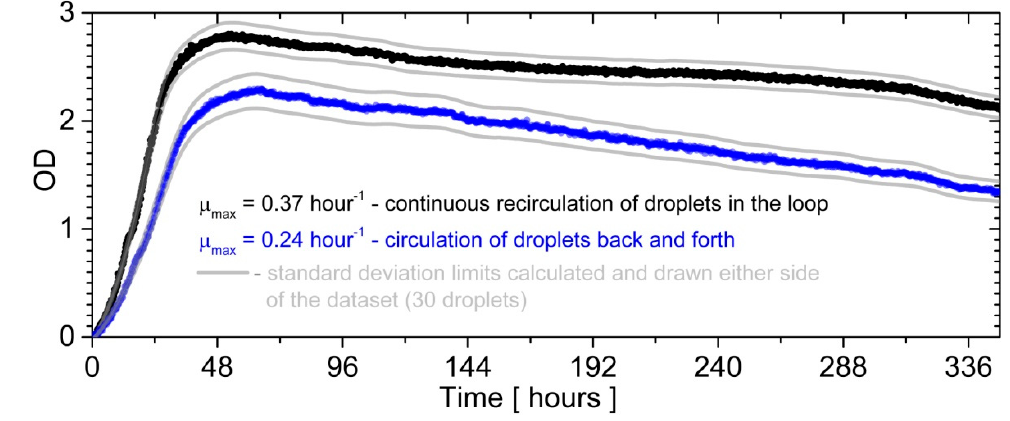
Figure 4. The bacterial growth curve for the long-term incubation of droplets flowing in a microfluidic loop, compared with droplets flowing back and forth in the 1 m long tubing. The optical density (OD) was taken at 600 nm. The black and blue curves represent the average growth calculated from 30 droplets in each case. The maximum growth rate was calculated as a derivative of the OD function in time.